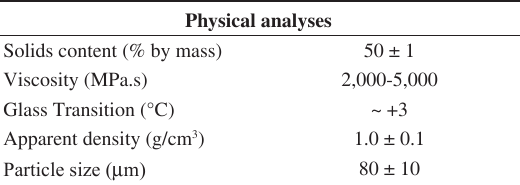
Table 4. Physical characteristics of styrene-butadiene copolymer dispersion. Physical analyses